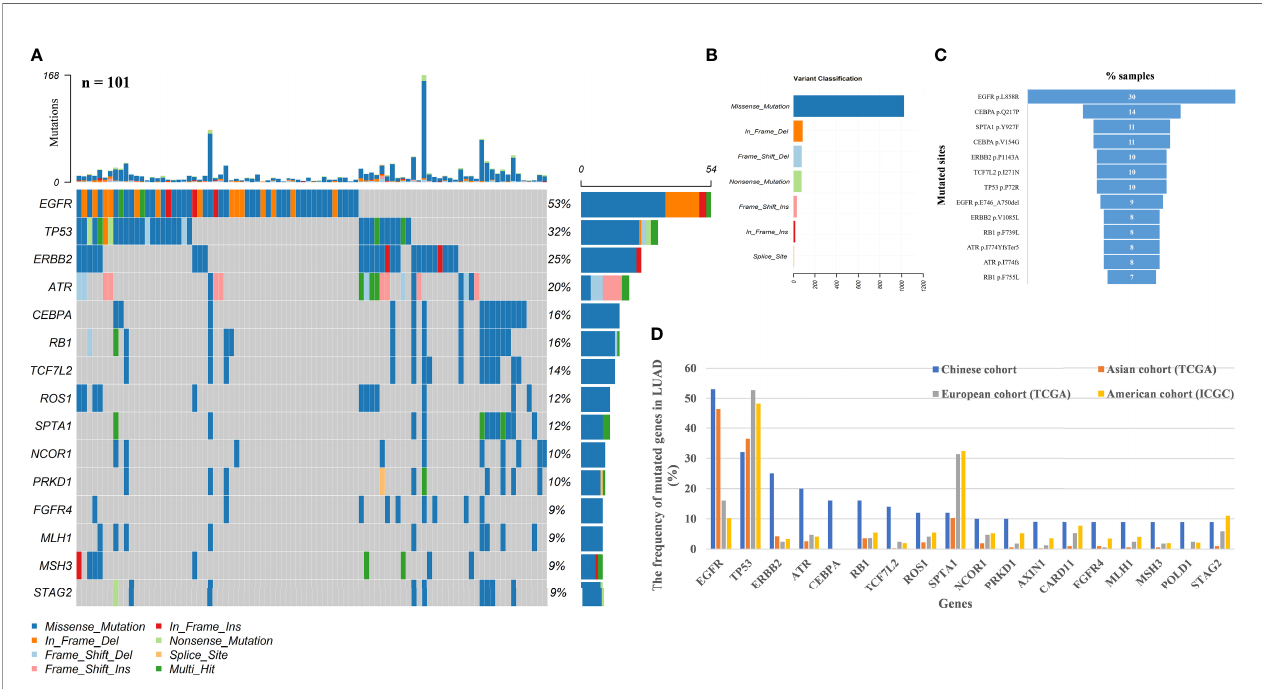
FIGURE 2 | Mutational landscape of 101 Chinese LUAD patients. (A) 15 top frequently mutated genes are shown. The X-axis represents the sample of each patient, and the Y-axis represents the mutated genes and the mutation frequency of each mutated gene. (B) Display of variation classi fi cation. (C) High frequency hot spot mutated sites in LUAD patients. (D) Comparison of the frequency of 18 signi fi cantly mutated genes identi fi ed in Chinese LUAD patients with that in the TCGA and ICGC cohorts. TCGA, The Cancer Genome Atlas. ICGC, International Cancer Genome